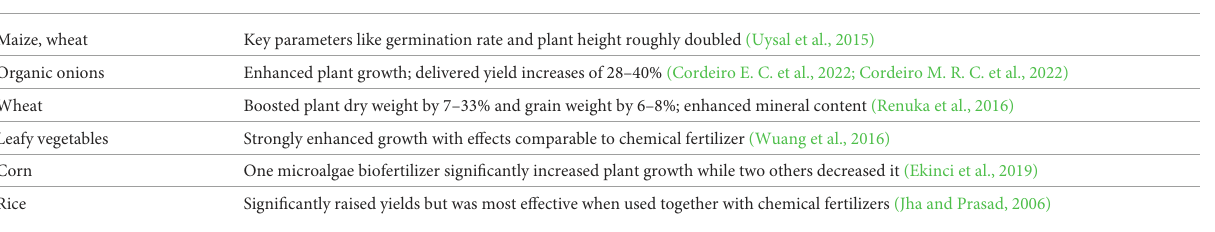
TABLE 4 Efficacy of microalgae-based biofertilizers on crops. Crops Study findings Maize, wheat